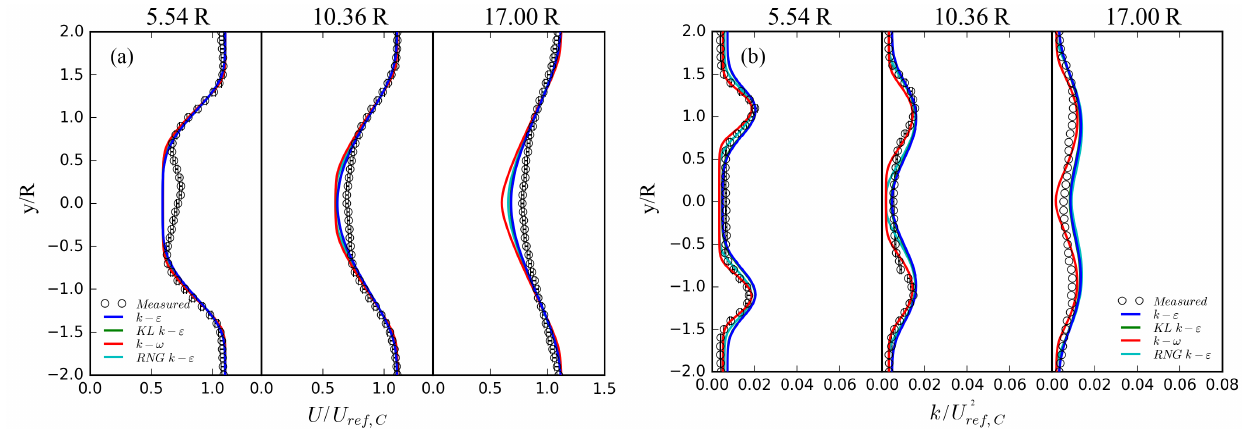
Figure 11. (a) Normalized axial velocity and (b) normalized turbulence kinetic energy computed for the two in-line model wind turbines (case C1) at x/R = 5 . 54, 10.36 and 17.00 downstream of the first wind turbine for a separation distance of 18 . 00 R . Different turbulence models are used along with the undistributed